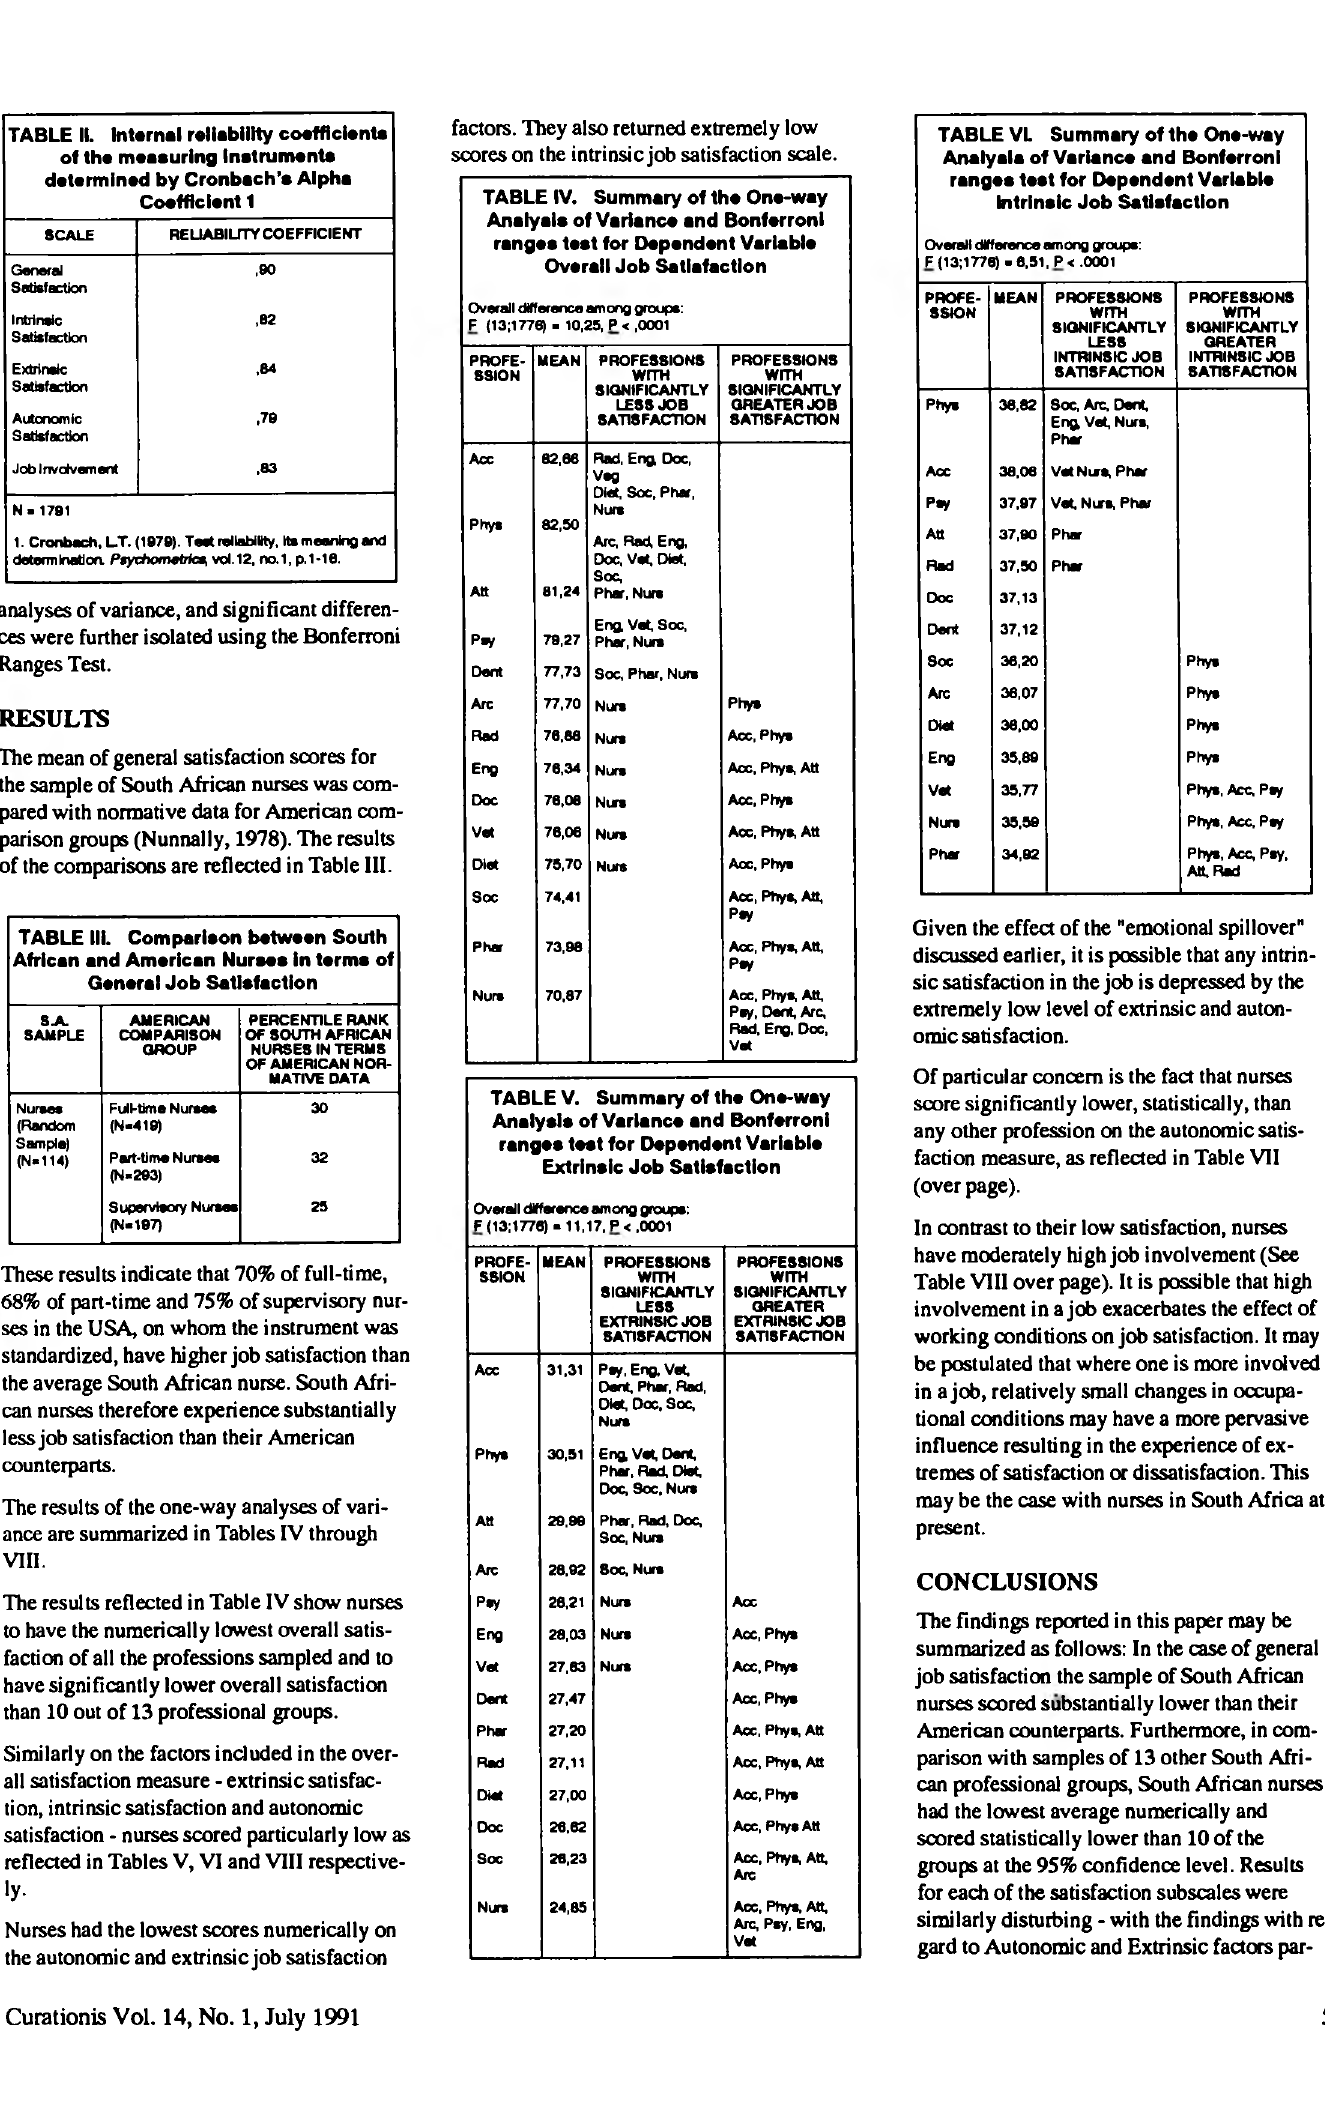
TABLE VL Summary of the One-way Analyala of Variance and Bonferroni ranges test for Dependent Variable Intrinsic Job